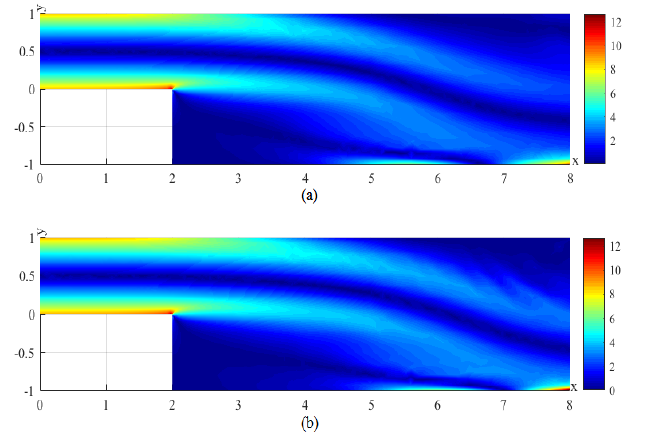
Figure 16. ( a ) The velocity magnitude for the CNMFE solution at t = 10. ( b ) The velocity magnitude for the RDRCNMFE solution at t = 10.